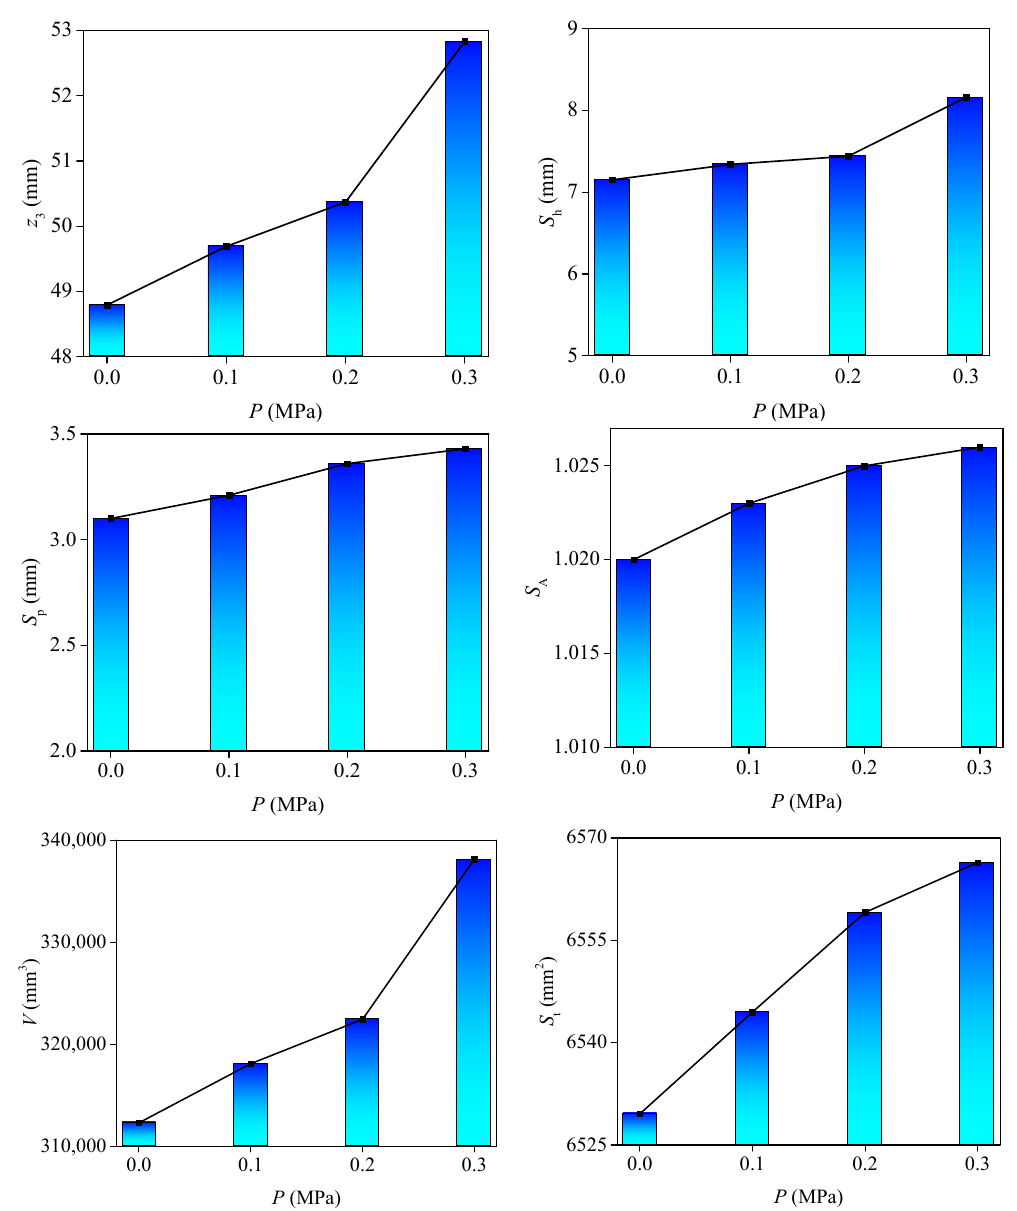
Figure 9. Evolution of 3D morphology parameters of the structural plane under different seepage water pressures.